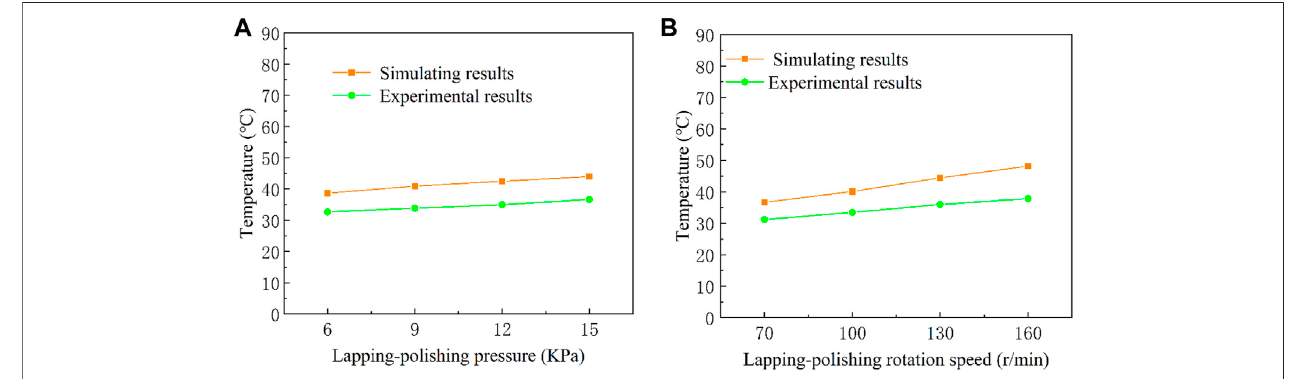
FIGURE 11 | Comparisonofsimulatingand experimental results. (A) Under different lapping-polishingpressures, (B) Under differentlapping-polishing rotation speed.